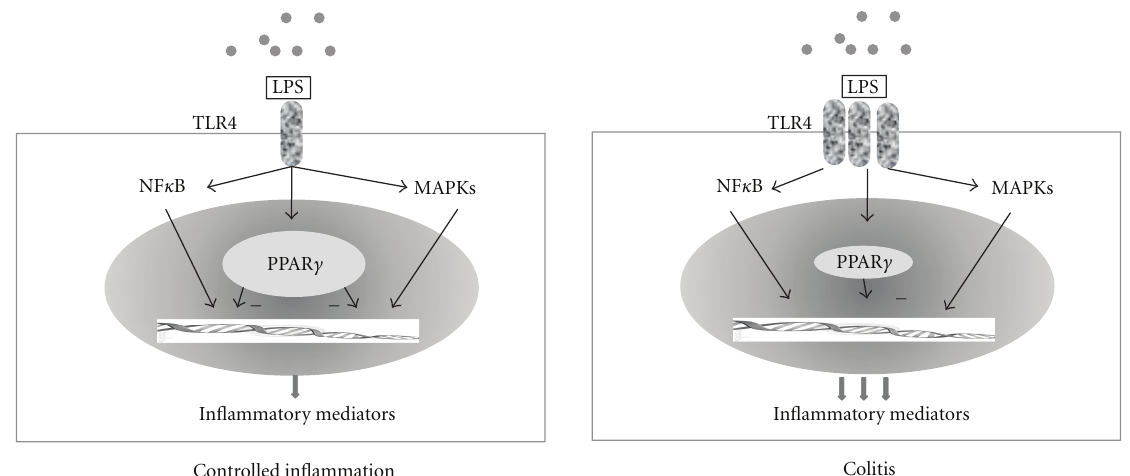
Figure 1: An hypothetical model of influence of PPAR γ expression in ulcerative colitis. Induction of PPAR γ expression in epithelial cells by bacterial lipopolysaccharide- (LPS-) activated TLR4, in turn leads to break NF κ B and MAPK pathways to produce inflammatory mediators. The reduced expression of PPAR γ together with TLR4 upregulation might enhance the inflammatory mediators production thus resulting in mucosal